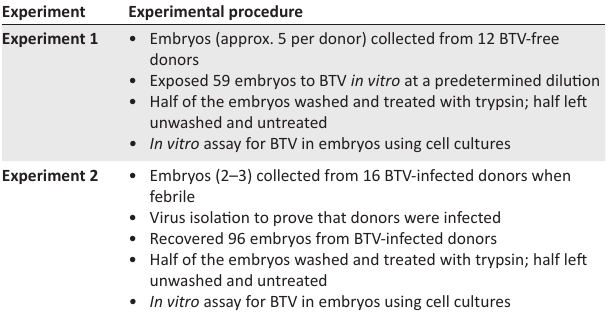
TABLE 1: A summary of the experimental procedure for establishing the infectivity of BTV from in vivo -derived ovine